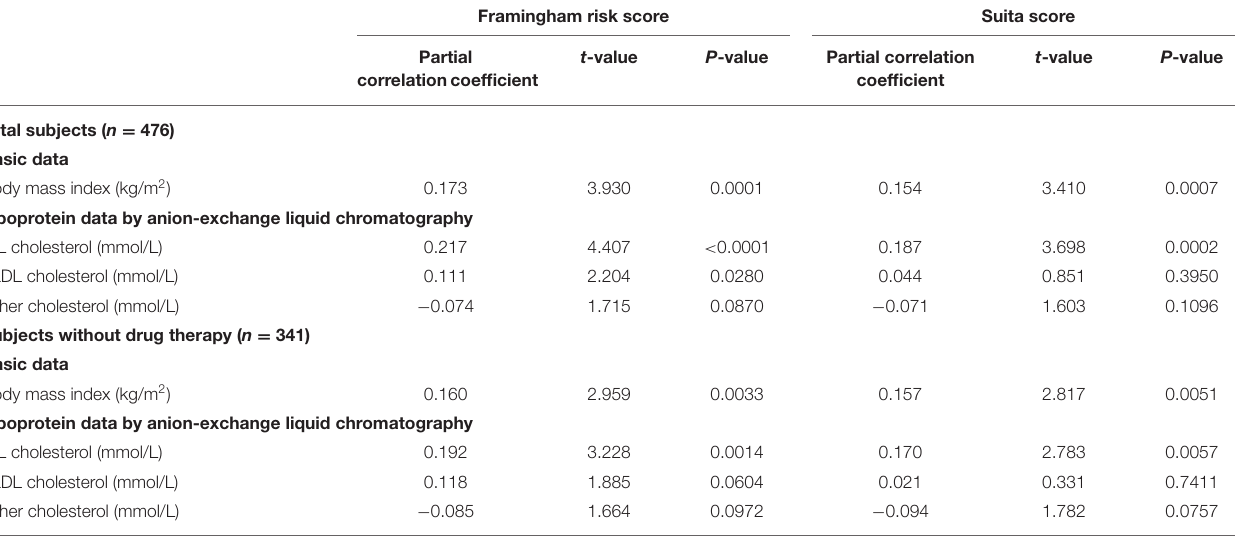
TABLE 3 | Multiple stepwise regression of body mass index and cholesterol levels of triglyceride-rich lipoproteins to Framingham risk score and Suita score.